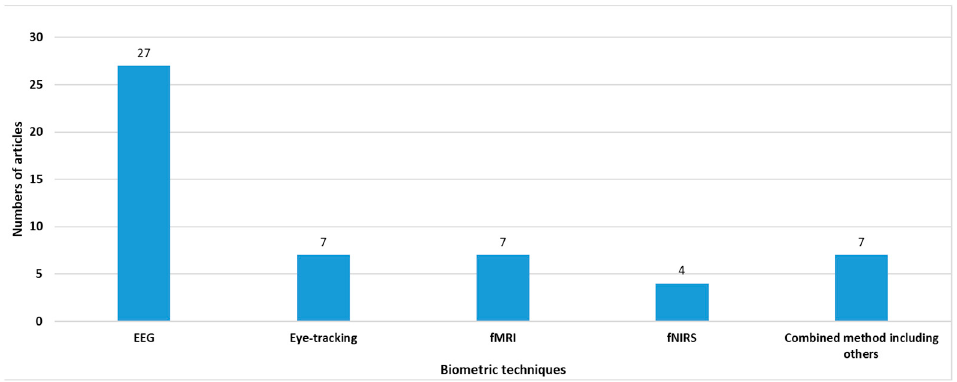
Figure 3. Biometric measurements techniques adoption.